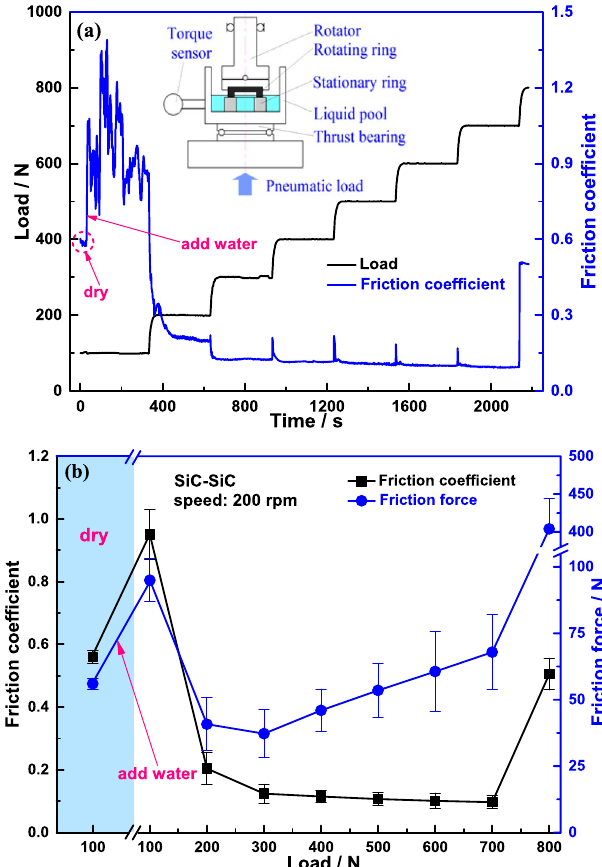
Figure 1. ( a ) Variation of friction coefficient between SiC-SiC friction interface with running time under different external loads at a rate of rotation of 200 rpm, corresponding to 0.5 m/s, from initial dry sliding to the addition of water with a standard Plint TE92 tribometer, the schematic of which is shown in the embedded figure. ( b ) The average value of the above variation curve at each lubrication state, or each load, is taken as the friction coefficient. The tests are repeated three times to check for reproducibility and the average value of the three experiments is taken as the final friction coefficient (the standard deviation is shown as the error bar). The friction force is obtained from the product of the friction coefficient and the external